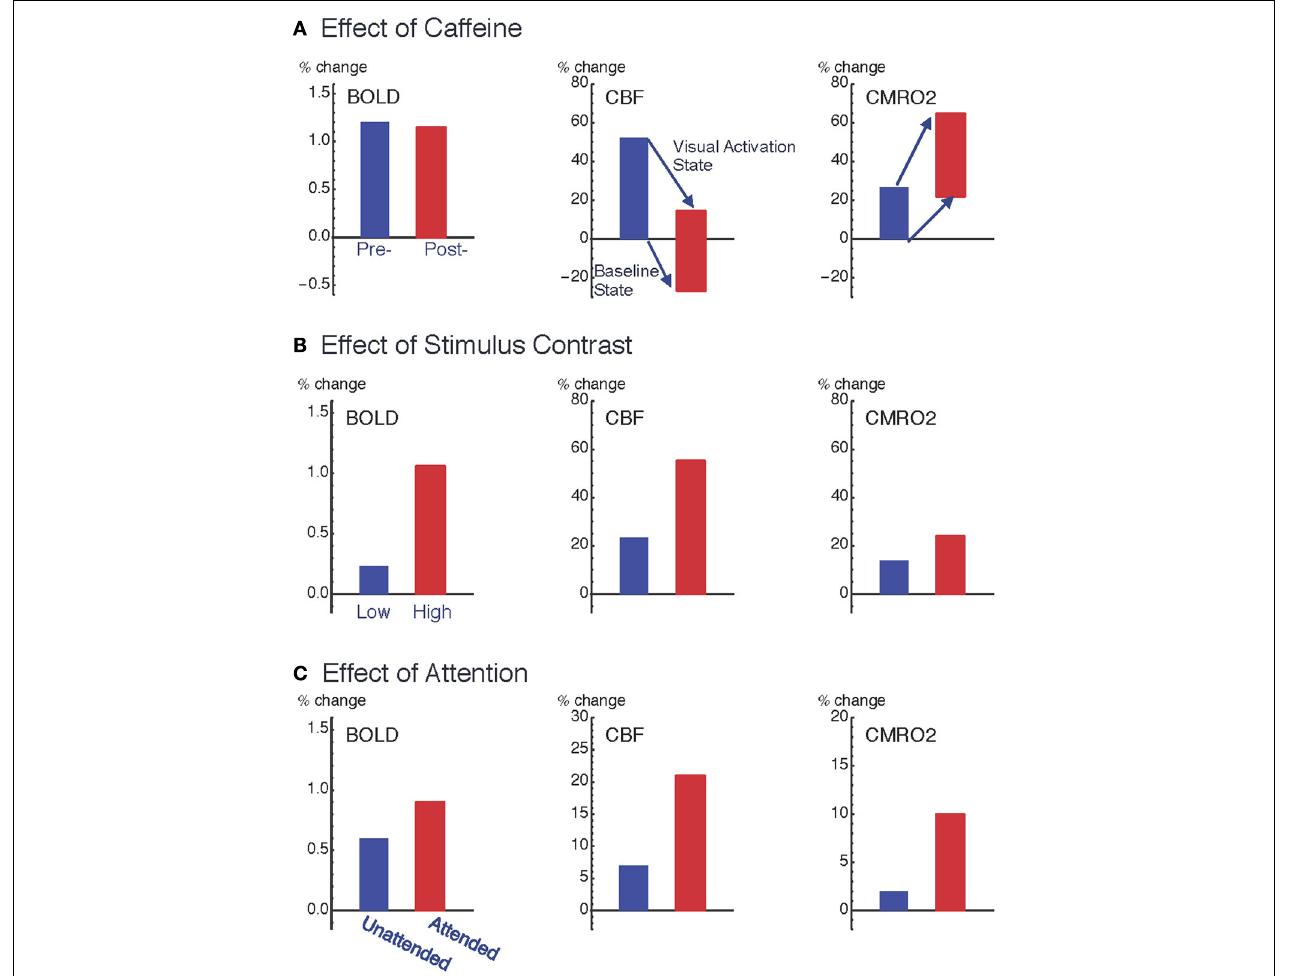
FIGURE 2 | Pattern of variation of the coupling ratio of CBF and CMRO 2 responses. Data from three studies of visual cortex show how responses are modulated by: (A) ingestion of 200mg caffeine (Perthen et al., 2008; Griffeth et al., 2011); (B) increasing stimulus contrast (Liang et al., 2013); and (C) increasing attention to a fixed stimulus (Moradi et al., 2012). For the caffeine data (A) , changes are as a percentage of pre-caffeine baseline state, and the plots for CBF (middle column) and CMRO 2 (right column) show both the baseline shift due to caffeine (the shift of the bottom of the bars) as well as the change in the activation